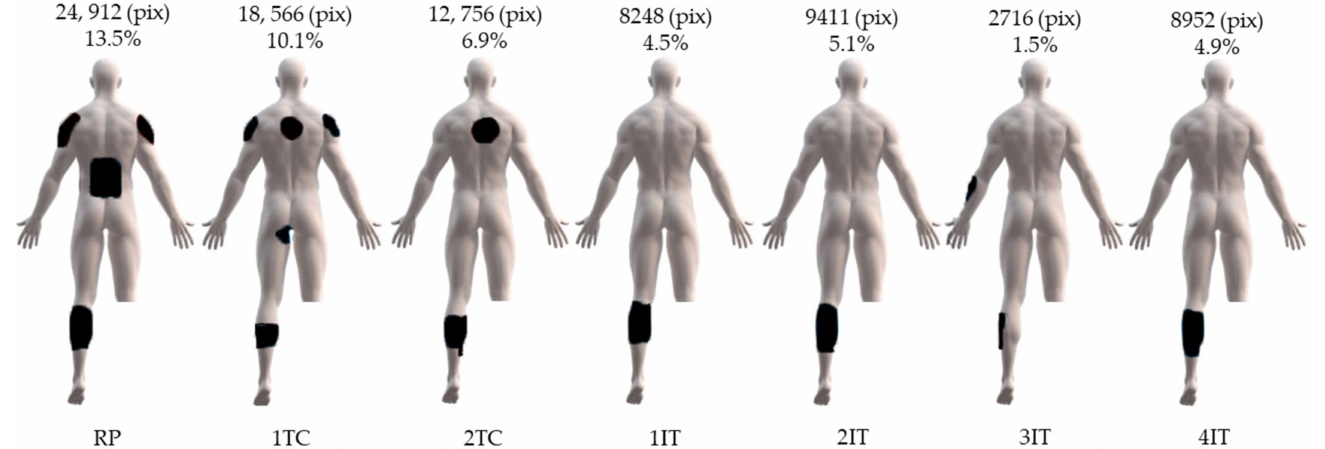
Figure 7. Digital pain drawings of the back body area of the representative player in different time moments (the same as shown in the GNSS data summary table). RP-recall pain, 1–2TC—following days of training camp, 1–4IT—following days of international tournament. Numbers represent the area of pain in pixels and the percentage of the whole back body area, individualized for the representative